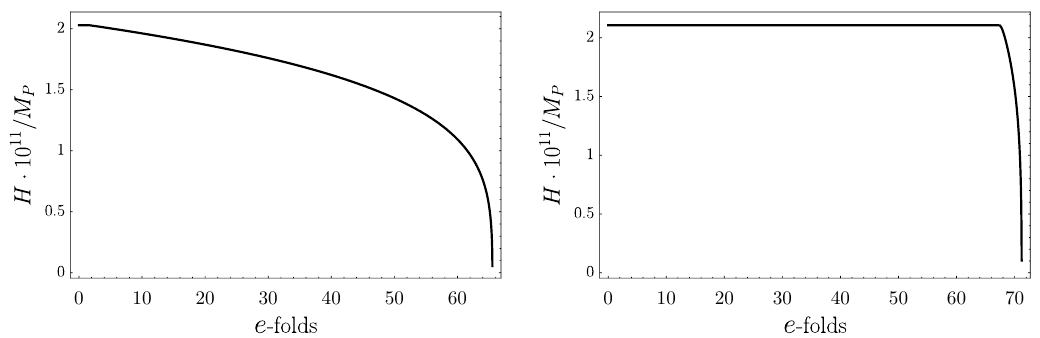
Figure 6 . Evolution of the Hubble parameter for set 1 (left) and set 2